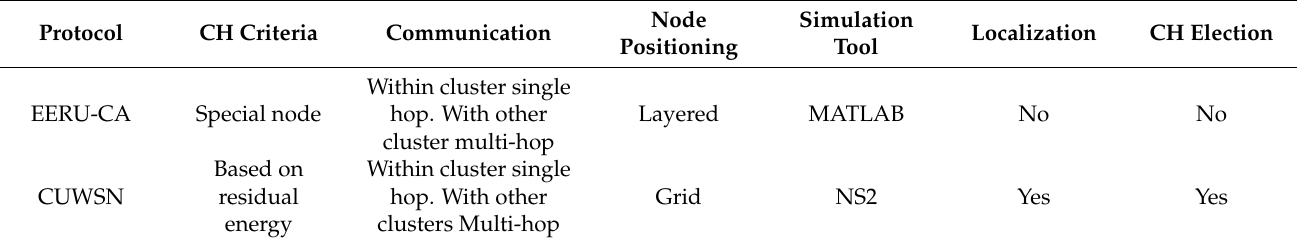
Table 5. Comparison of cluster-based routing